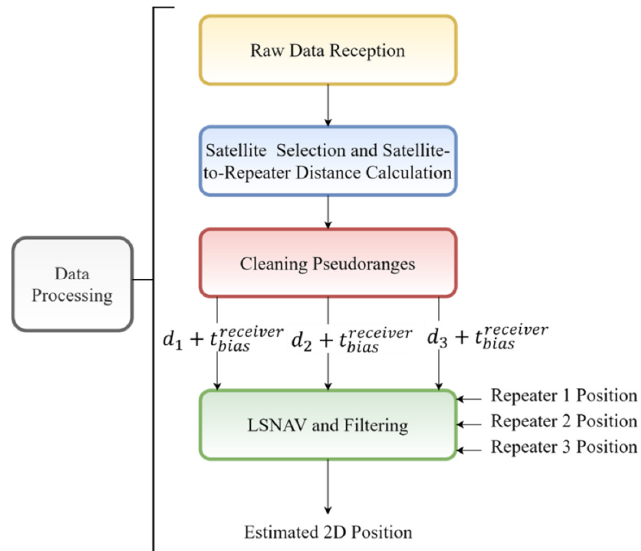
Figure 7. Flow of the algorithm.